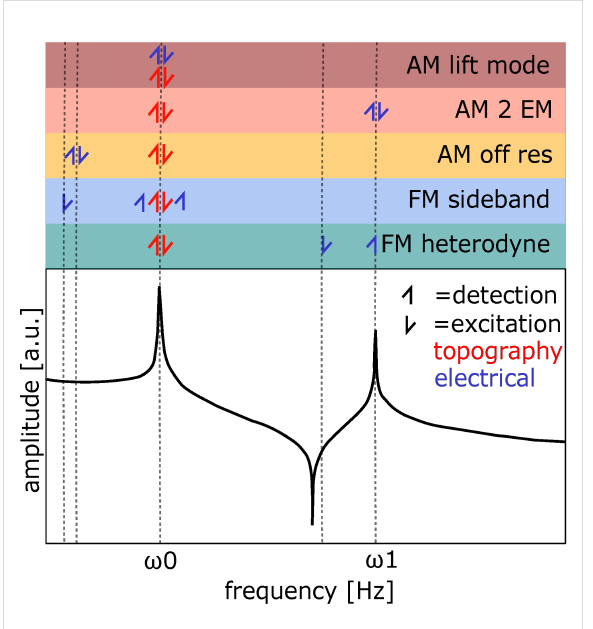
Figure 2: Overview of excitation and detection frequencies for KPFM methods used in this work. The lower part shows the transfer function of the cantilever, amplitude plotted vs frequency. The upper part shows excitation (arrow upwards) and detection (arrow downwards) for the corresponding methods with the respective frequencies. Red color is used for the topography signal and blue for the electrical excitation and detection. The color code in the upper part corresponds to plots in the results. Representation inspired by